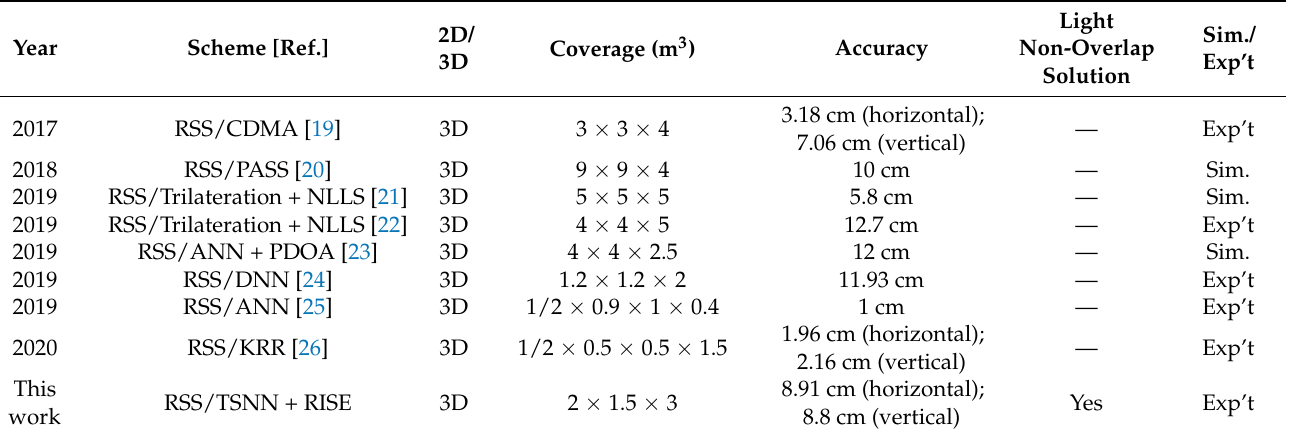
Table 1. Recent 3D RSS VLIP